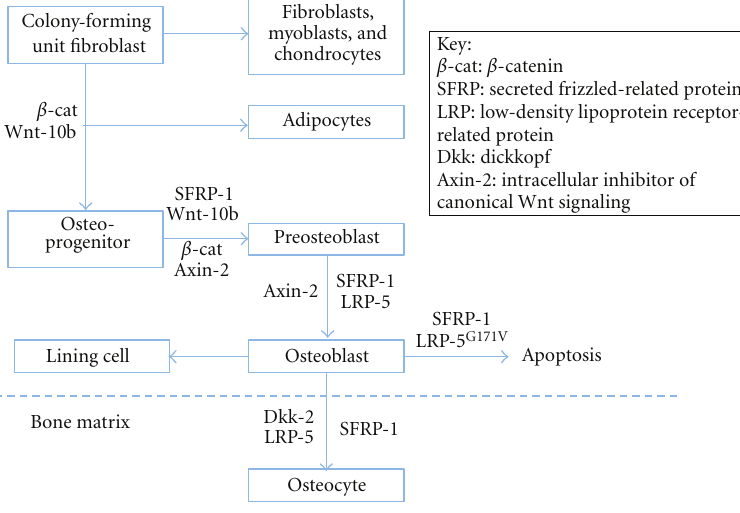
Figure 3: Role of canonical Wnt signaling in the control of